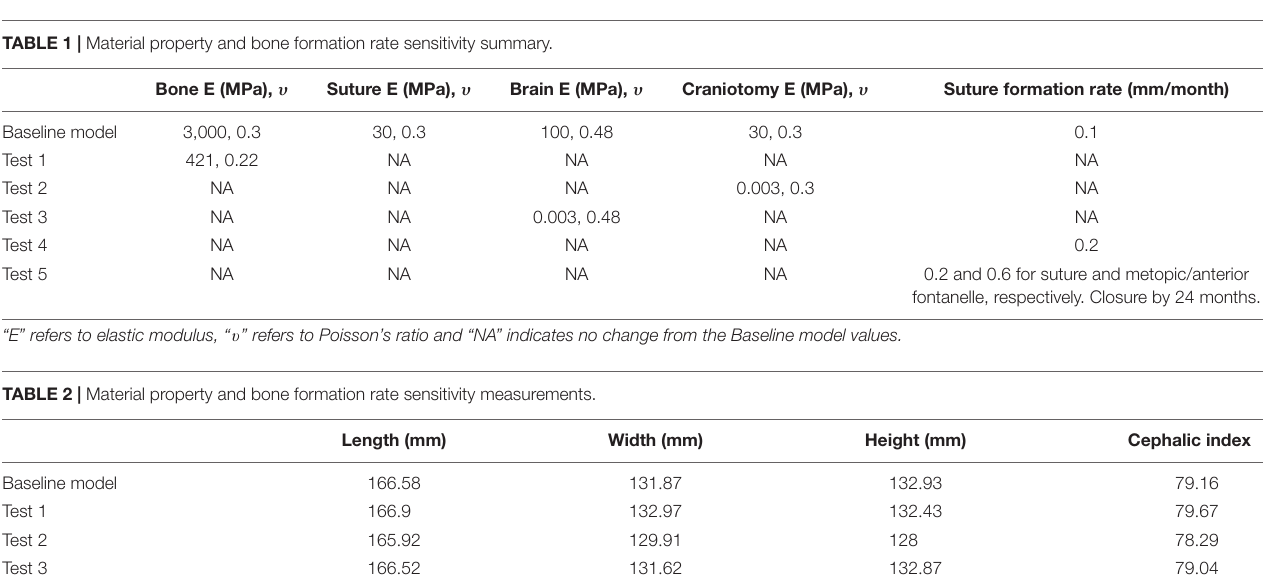
method, there was no greatly varying impact on morphological outcomes, with all scenarios matching close to follow up data. 159.9 mm, 129.7 mm and 129.1 mm, respectively. Cephalic index